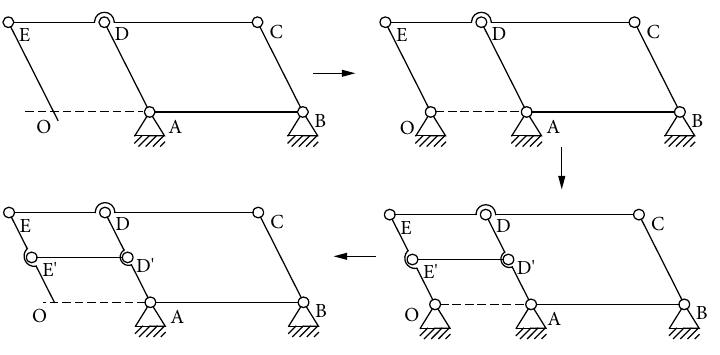
Figure 6: Expansion of VRC modular unit.